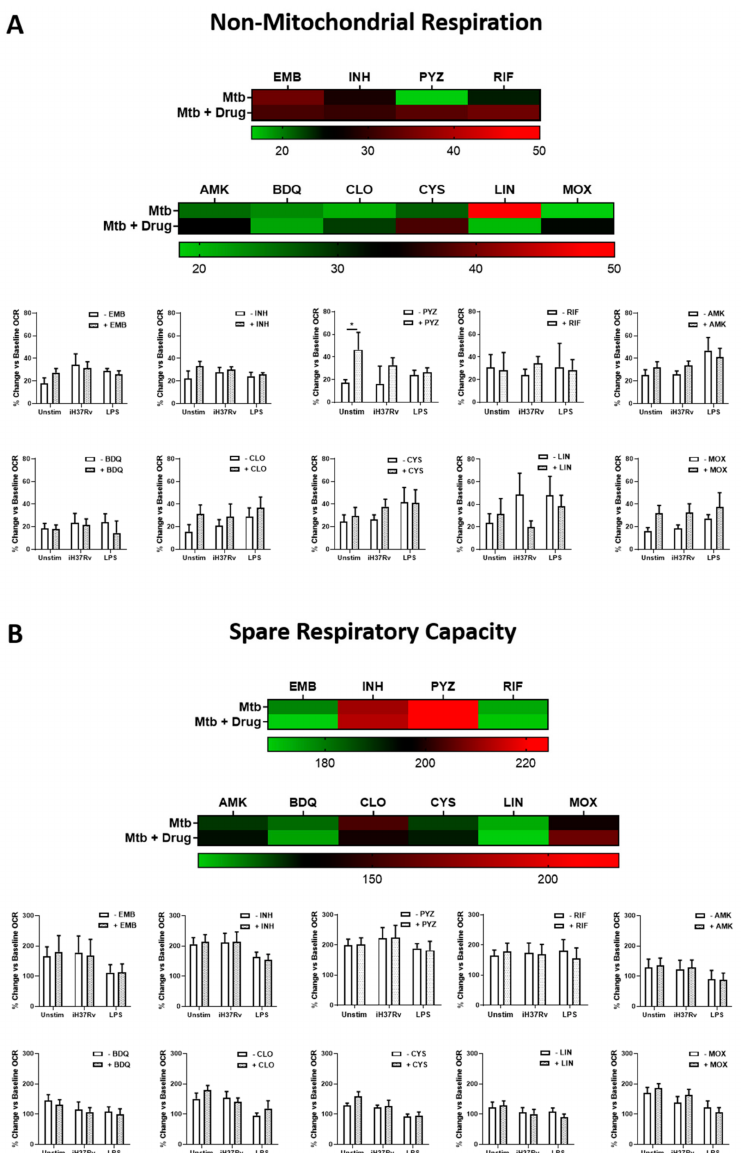
Figure 4. TB antimicrobials do not affect spare respiratory capacity or non-mitochondrial respiration in iH37Rv-Mtb- stimulated and LPS-stimulated hMDMs. hMDMs, differentiated from PBMCs isolated from healthy blood donors, were treated with ethambutol (5 µ g/mL), isoniazid (1 µ g/mL), pyrazinamide (2 µ g/mL), rifampicin (2 µ g/mL), amikacin (5 µ g/mL), bedaquiline (5 µ g/mL), clofazimine (2 µ g/mL), cycloserine (5 µ g/mL), linezolid (15 µ g/mL) or moxifloxacin (12.5 µ g/mL) three hours post stimulation with either iH37Rv-Mtb or LPS (100 ng/mL). 24 h post stimulation, ( A ) non-mitochondrial respiration and ( B ) spare respiratory capacity were determined utilising the Seahorse Extracellular Flux Analyser. Bars denote mean ± SEM * p < 0.05 (Two-way repeated measures ANOVA with Sidak’s multiple comparisons test). Ethambutol (EMB, n = 7); isoniazid (INH, n = 6); pyrazinamide (PYZ, n = 7); rifampicin (RIF, n = 9); amikacin (AMK, n = 5); bedaquiline (BDQ, n = 6); clofazimine (CLO, n = 6); cycloserine (CYS, n = 4); linezolid (LIN, n = 8); moxifloxacin (MOX, n =